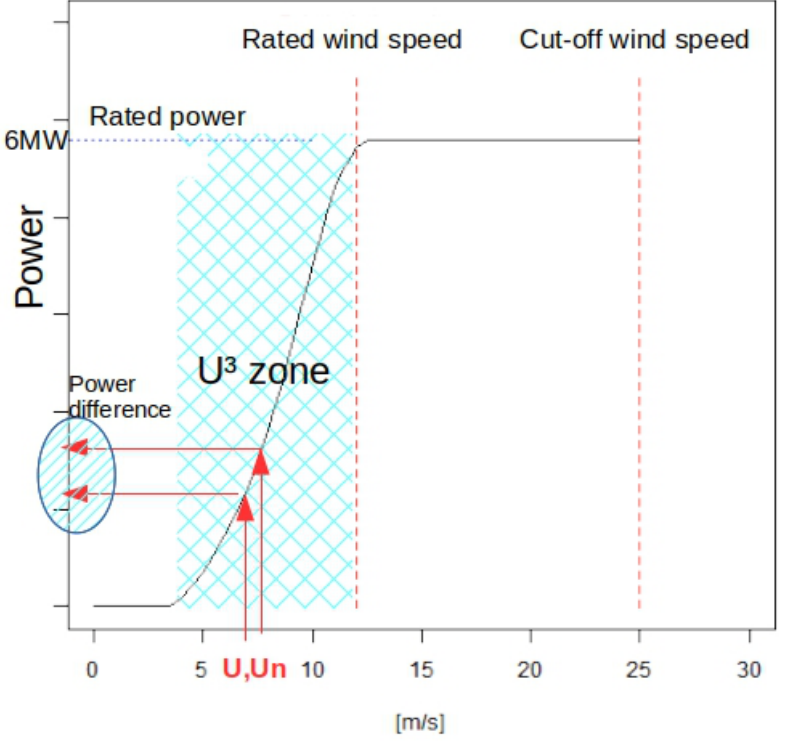
Figure 6. The normalized wind speed U n and the U in the U 3 zone of a typical power curve and the subsequent considerable power